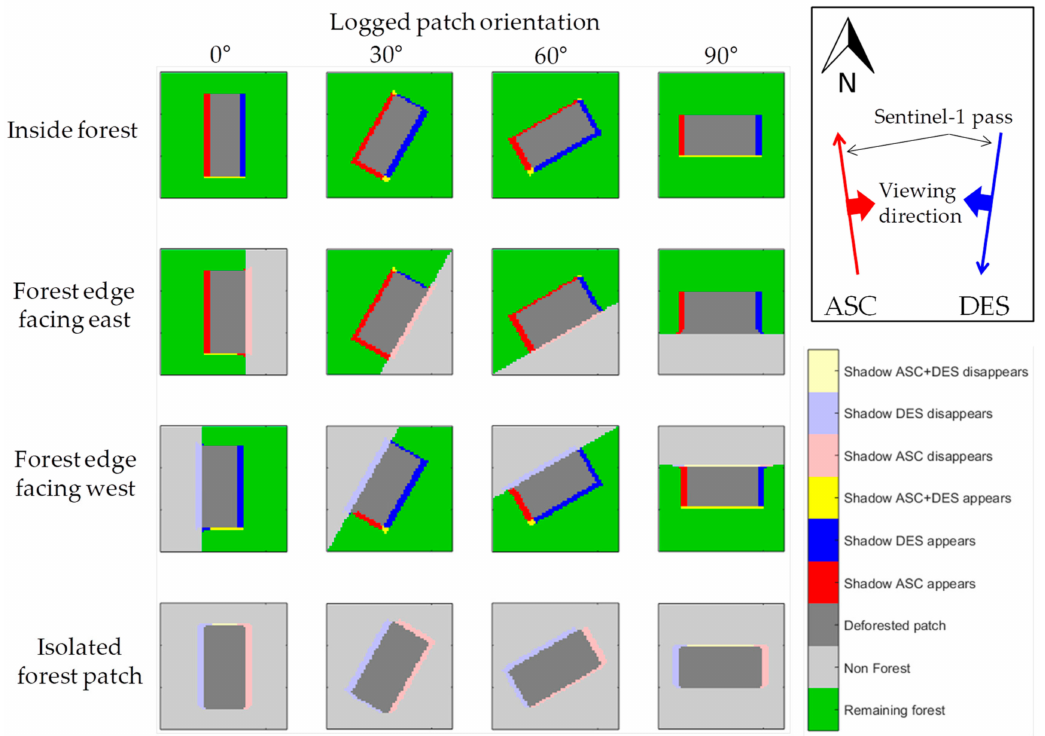
Figure 4. Shadows that appear or disappear when a forest patch is deforested, depending on the orbit orientation (ascending or descending), the patch orientation, and the configuration (patch inside a forest, at the edge of a forest, or isolated). The figure is simulated for the Sentinel-1 configuration (right-looking with 98.18 ◦ orbit inclination) which is summarized in the frame on the top right. Shadows that appear are characterized by a sudden drop of backscatter in the S1 time